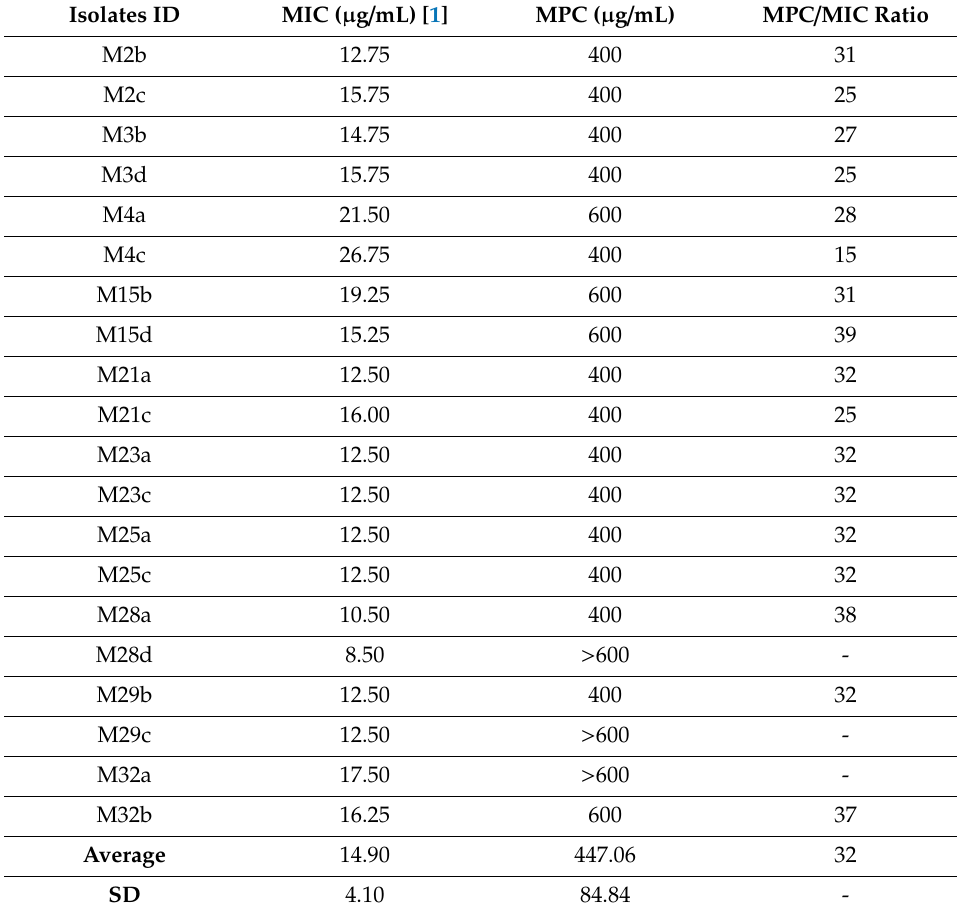
Table 1. Minimum inhibitory concentration (MIC), mutant prevention concentration (MPC), and MIC / MPC ratio of nisin against the enterococci collection obtained from the oral cavity of dogs with periodontal disease